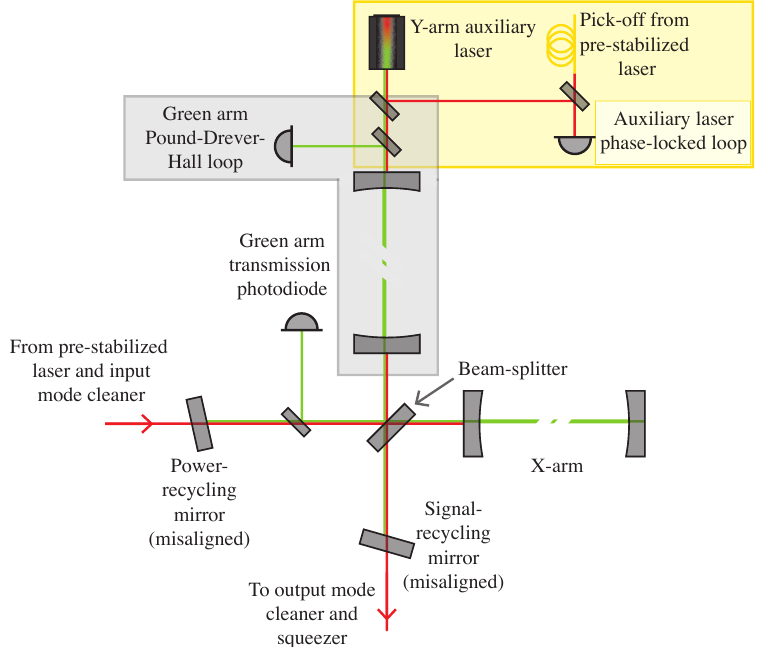
Figure 2. Interferometer layout during the first stage of lock acquisition: arm-length stabilization. The arm-length stabilization uses auxiliary lasers in the end stations (only the Y-arm is shown for simplicity), which emit beams at 1064 nm and 532 nm. The lasers are phase-locked to the pre- stabilized laser which is delivered to the end station by optical fiber (yellow box). The green laser is then locked to the arm cavity through a Pound–Drever–Hall loop on reflection (gray box). The ALS system consists of two auxiliary green laser sources at each end station. The end station lasers are phase-locked to the main laser, then frequency-doubled to generate 532 nm (green) light which is injected into the arm cavities. Each ALS laser is then locked to their respective arm